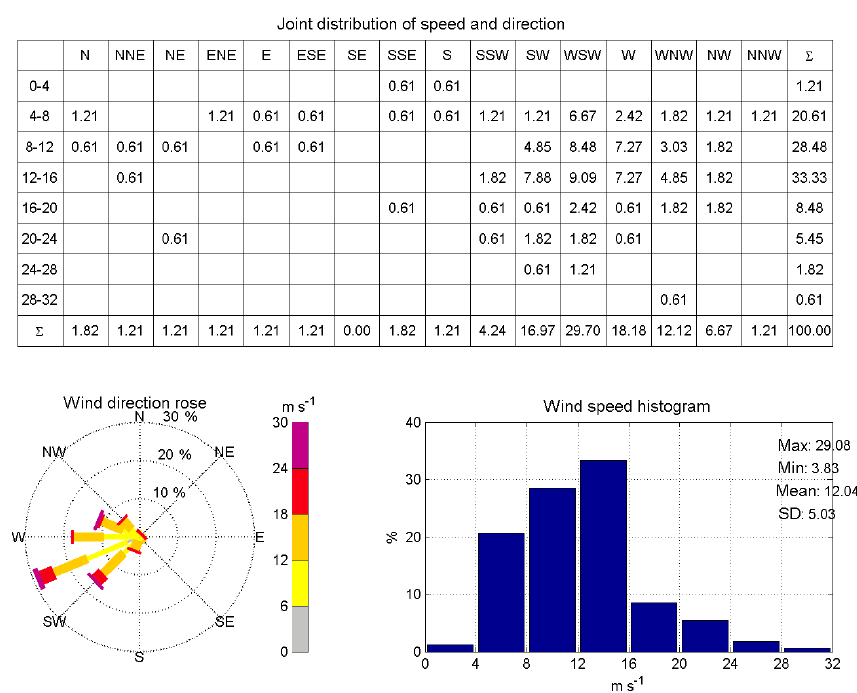
Figure 7. For the 180 cases where there was no wind increase above warm-core eddies: distribution in % of wind speed and direction and ms − 1 (top); wind direction rose (bottom left) and wind speed histogram (bottom right) at the entrance of the eddy upstream.